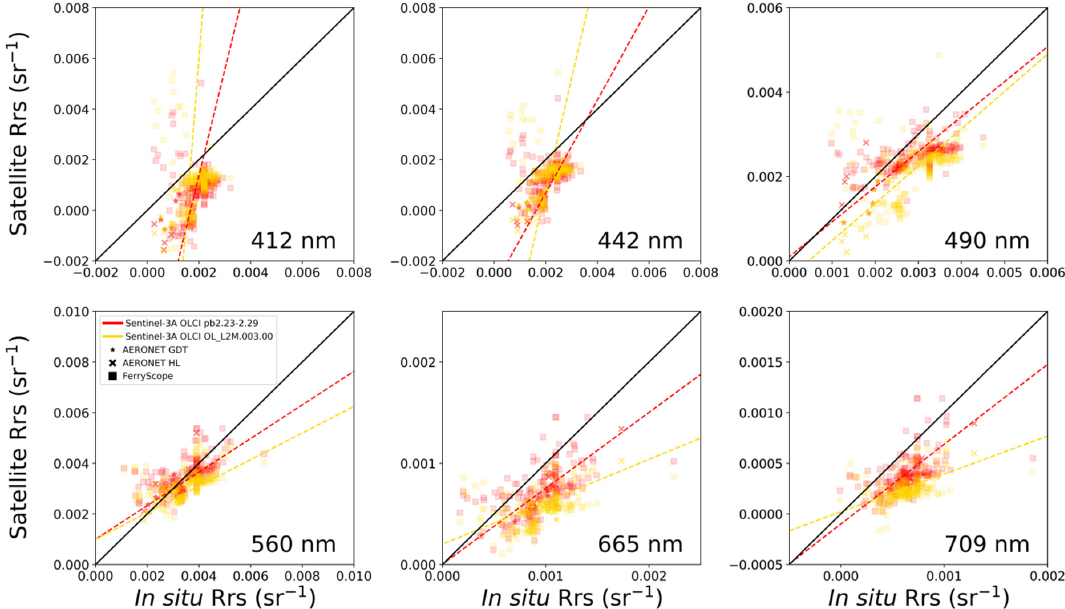
Figure 4. Scatter plots of satellite R rs versus in situ R rs for OLCI-A processing baseline 2.23–2.29 (red points and dashed line), OLCI-A processing baseline OL_L2M.003.00 (yellow points and dashed line), at 412, 442, 490, 560, 665 and 709 nm. Crosses are in situ AERONET-OC HLT R rs , stars are in situ AERONET-OC GDL R rs , squares are in situ Alg@line R rs . Table 2. Statistical results from the comparison between in situ and OLCI-A, pb 2.23–2.29 and OL_L2M.003.00 𝑅 (cid:3045)(cid:3046) (𝜆) . The metrics were computed using type-II regression for the slope ( S ), inter- cept ( I ), Pearson correlation coefficient (r), root-mean-square difference (RMSD— Ψ ), the bias ( δ ), bias-corrected root-mean-square error ( Δ ) and the relative percentage difference (RPD). Metrics for the processors with the best performance at each band are given in bold. N is the number of match- ups, with TOT being the total, GDL is the AERONET-OC site the Gustav Dalen Lighthouse, HLT is the AERONET-OC site the Helsinki lighthouse and Ferry are the Alg@line data. Statistical Quantities